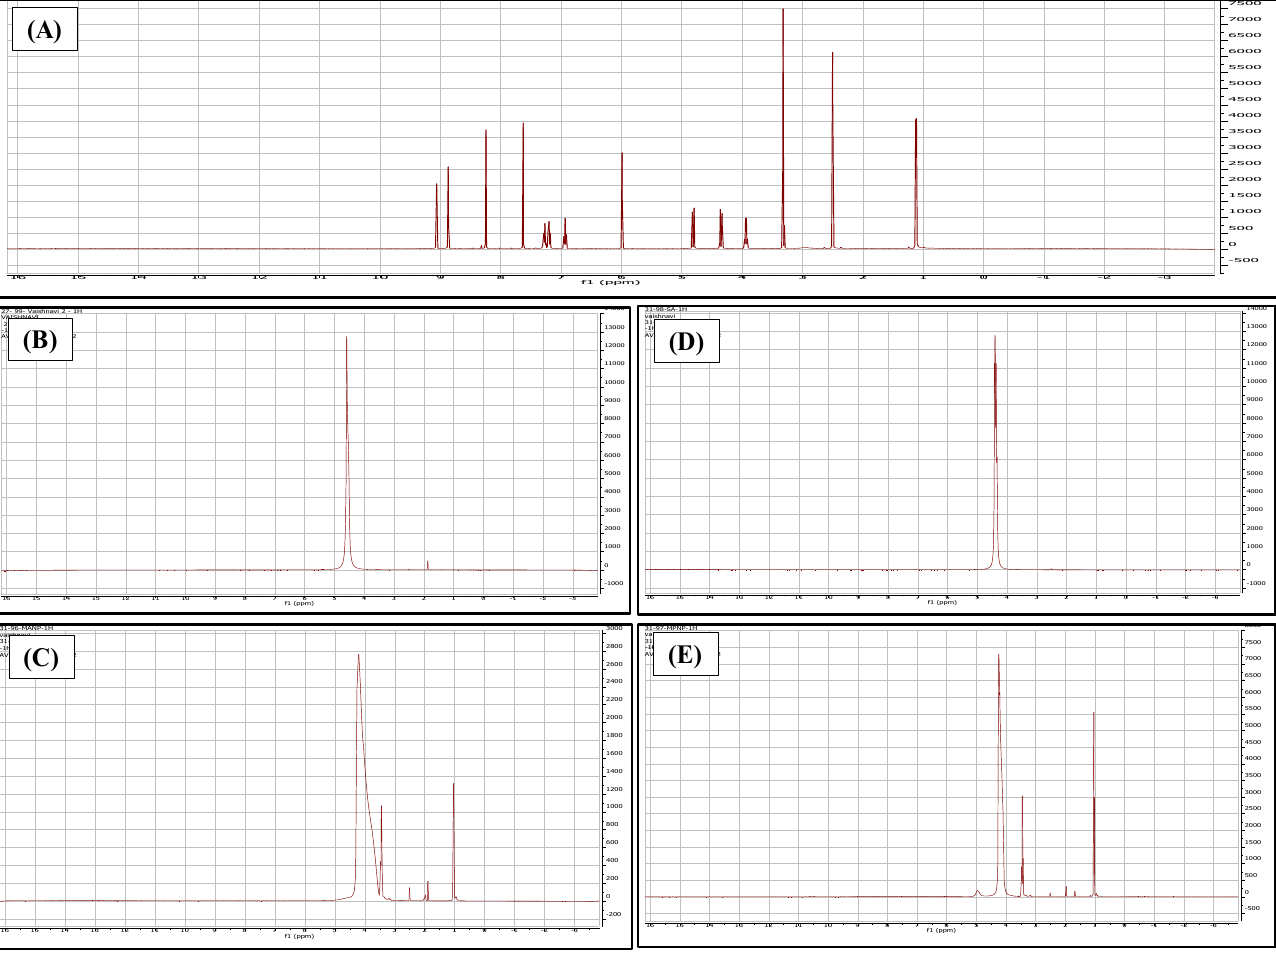
Figure 6. NMR spectra of ( A ) voriconazole, ( B ) chitosan, ( C ) VCZ-MA-NPs, ( D ) sodium alginate, and ( E ) VCZ-MP-NPs (where X axis is chemical shift in ppm while Y axis is intensity scale of spectral line). The percentage entrapment efficiency (%EE) of VCZ-MA-NPs and